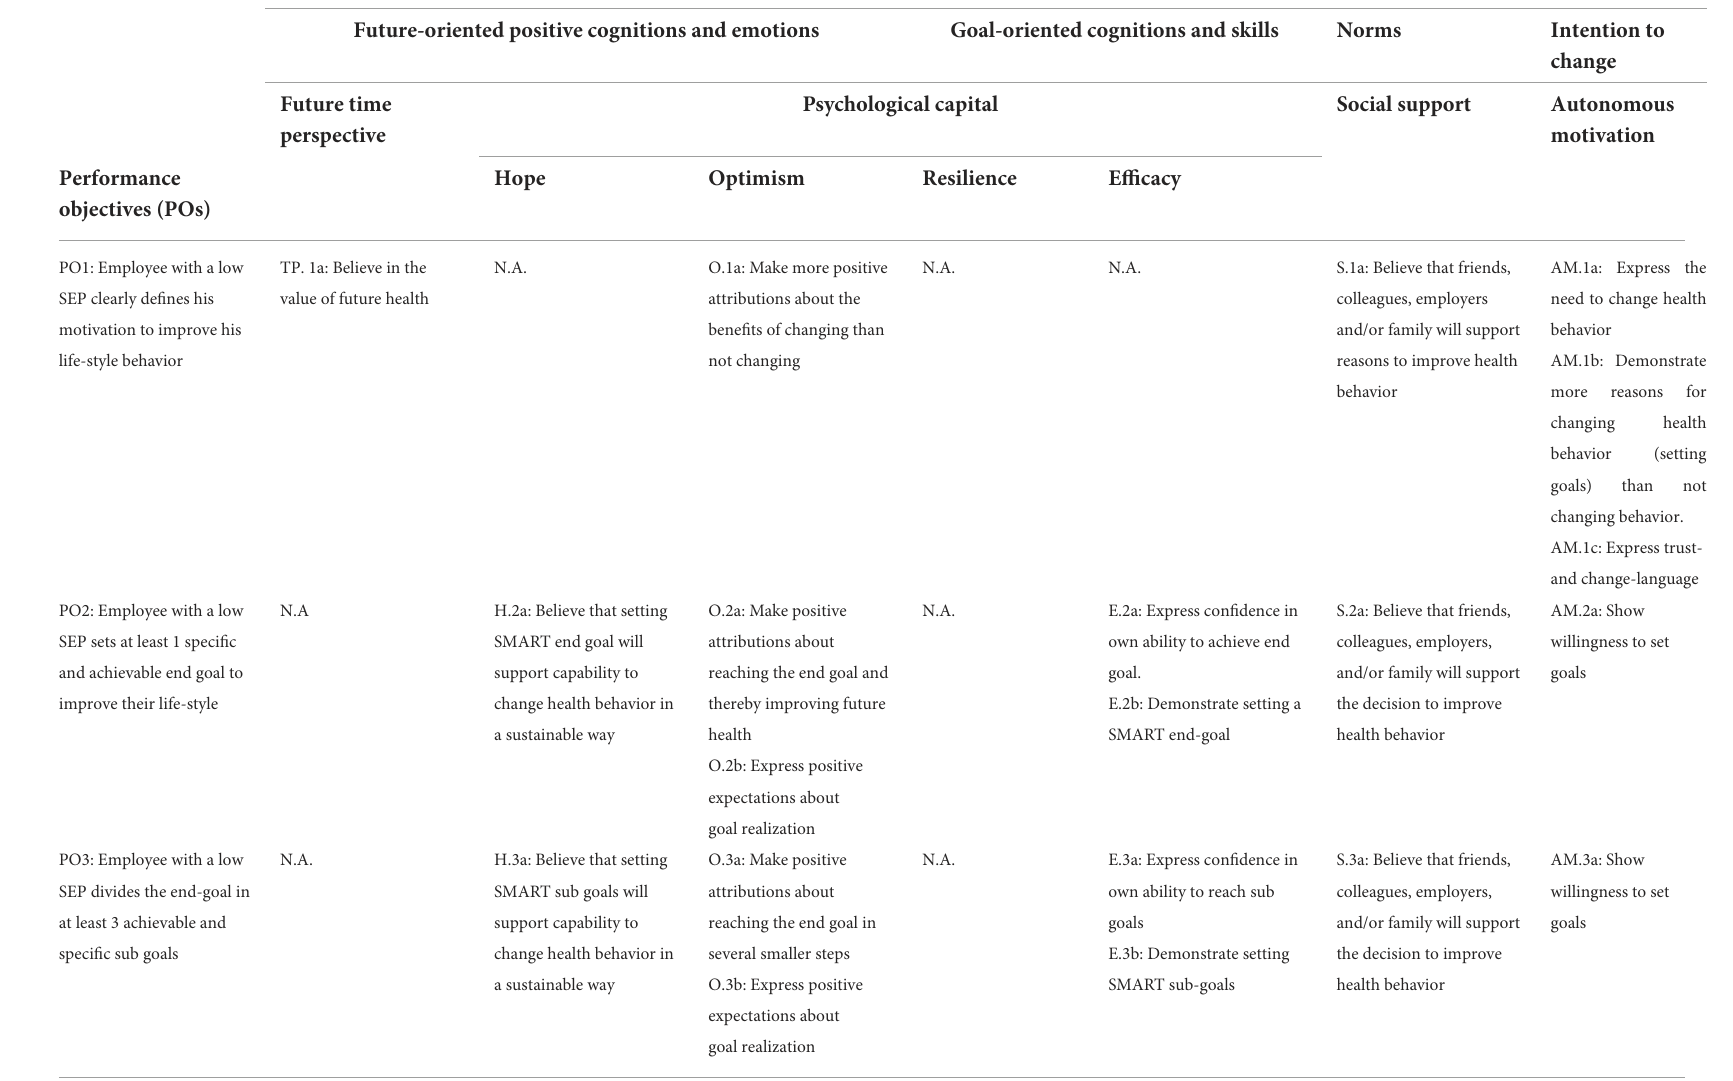
TABLE 1 Performance objectives (POs), determinants, and change objectives (COs) in the Future Positive micro-intervention. Change objectives (COs) for each relevant determinant Future-oriented positive cognitions and emotions Goal-oriented cognitions and